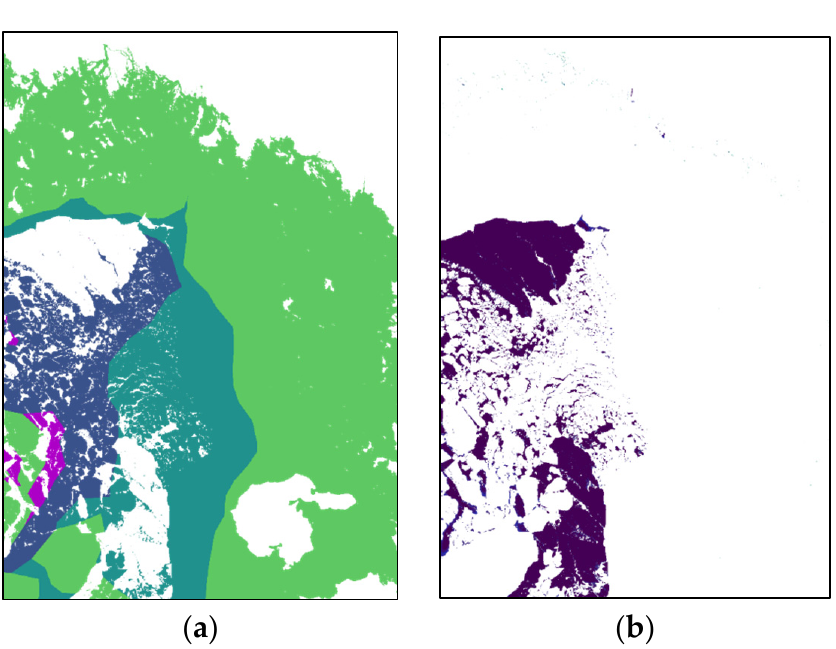
Figure 5. ( a ) Ice mask overlaid with the BSH Ice Chart for 22 March 2019; ( b ) Water mask for 22 March 2019.